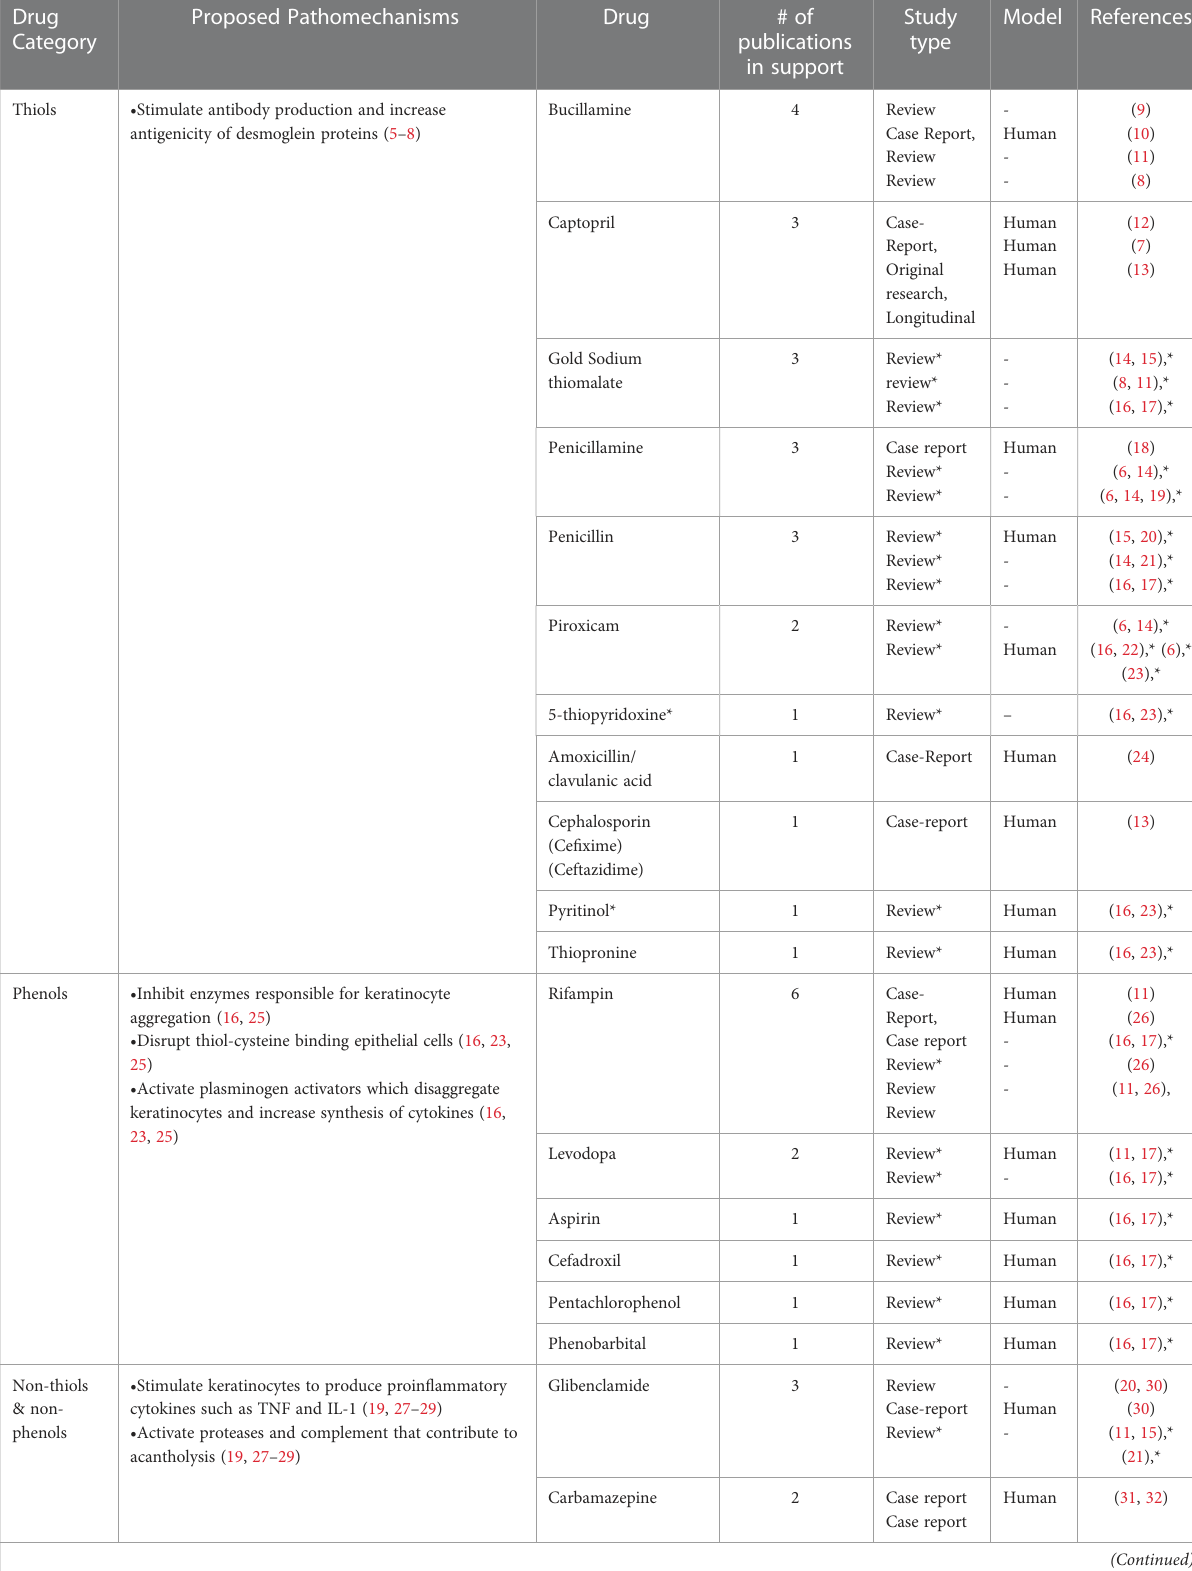
TABLE 2 Studies in support of the hypothesis that PV is triggered or exacerbated by